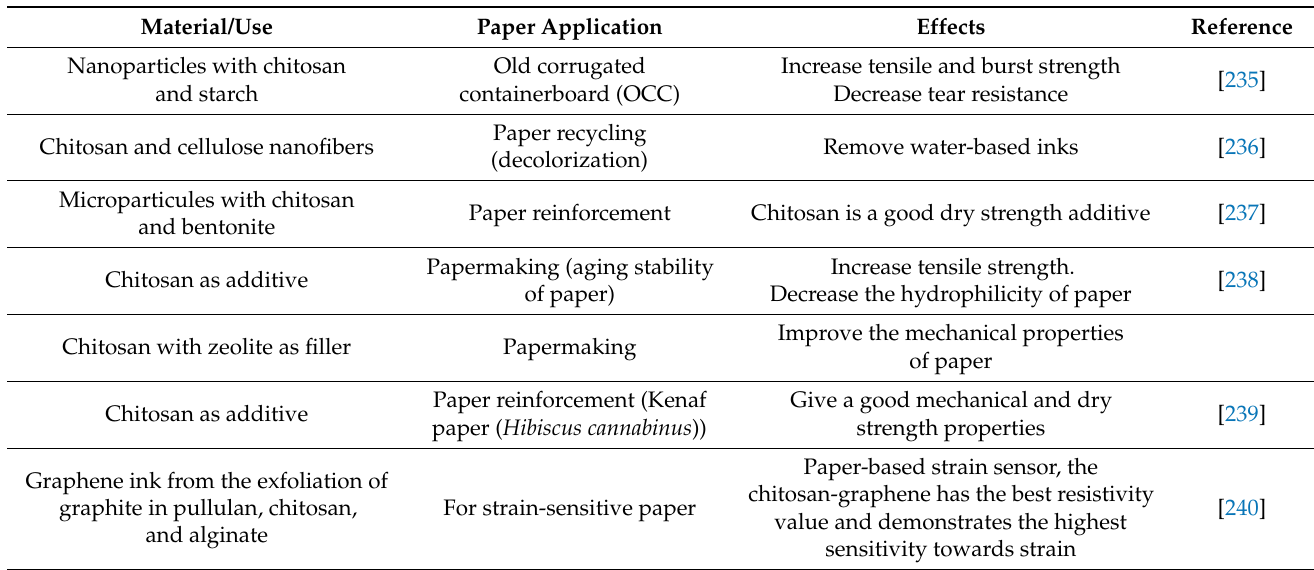
Table 9. Effects of chitosan in paper production.